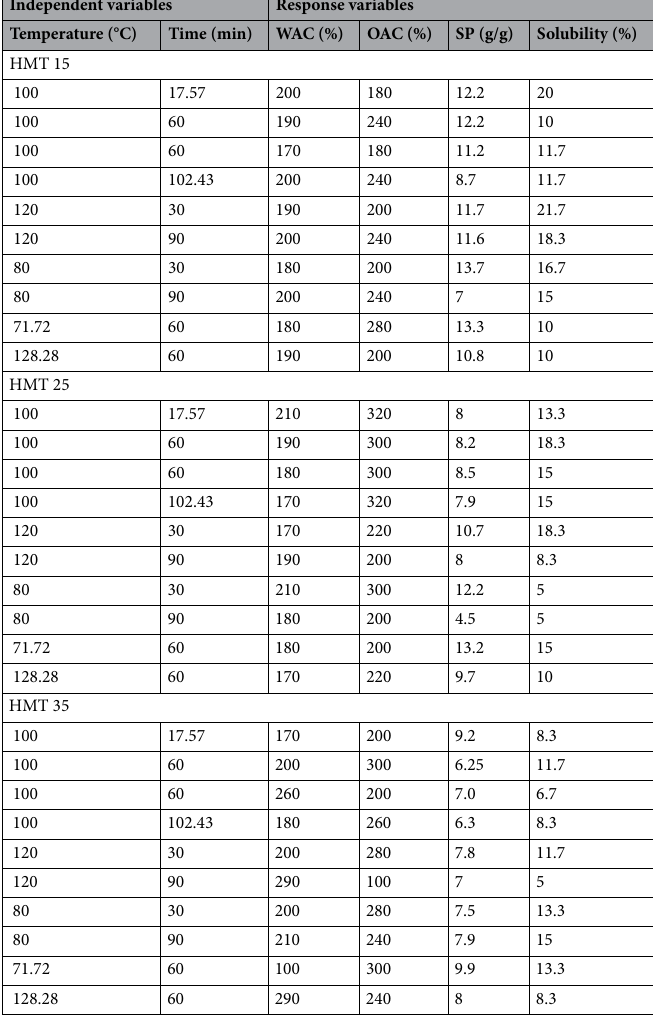
Table 4. Levels of process variables and values of functional properties for heat-moisture treated Bambara groundnut under different treatment conditions. WAC: water absorption capacity; OAC: oil absorption capacity; SP: swelling